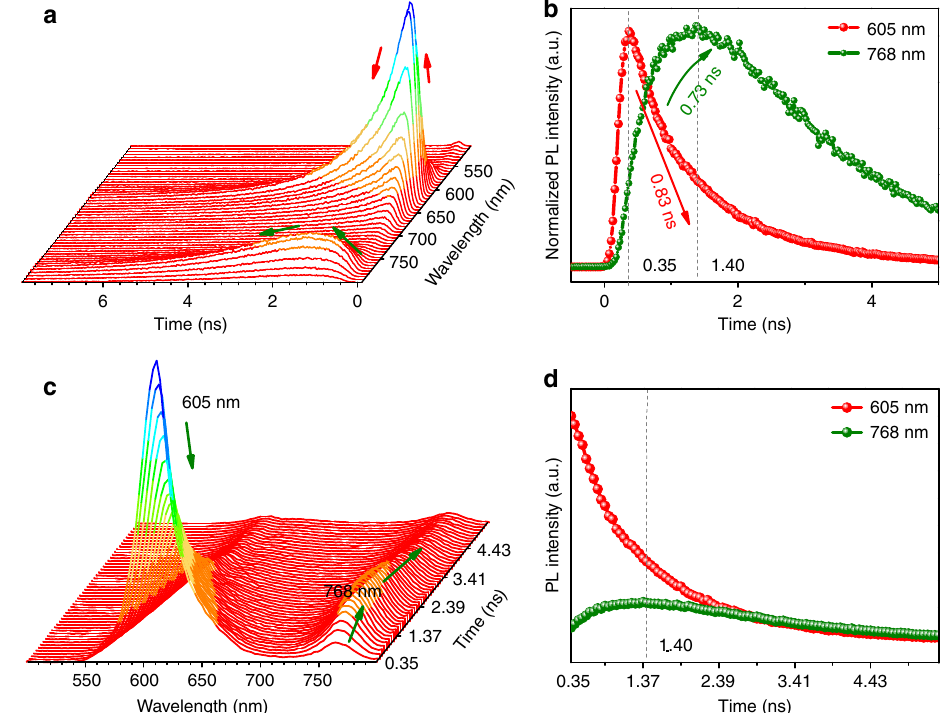
Fig. 4 Time-resolved fl uorescence properties of microcrystalline state BDP1. a Time-resolved fl uorescence decay curves of BDP1 at emission wavelength ( λ em ) of 500 – 800 nm. b Fluorescence decay curves of BDP1 at emission wavelengths of 605 and 768 nm. c Time-resolved emission spectra of BDP1 at the detection time from 0.35 to 5.45 ns d Time-resolved emission intensity variation of BDP1 at 605 and 768 nm. All samples measured were